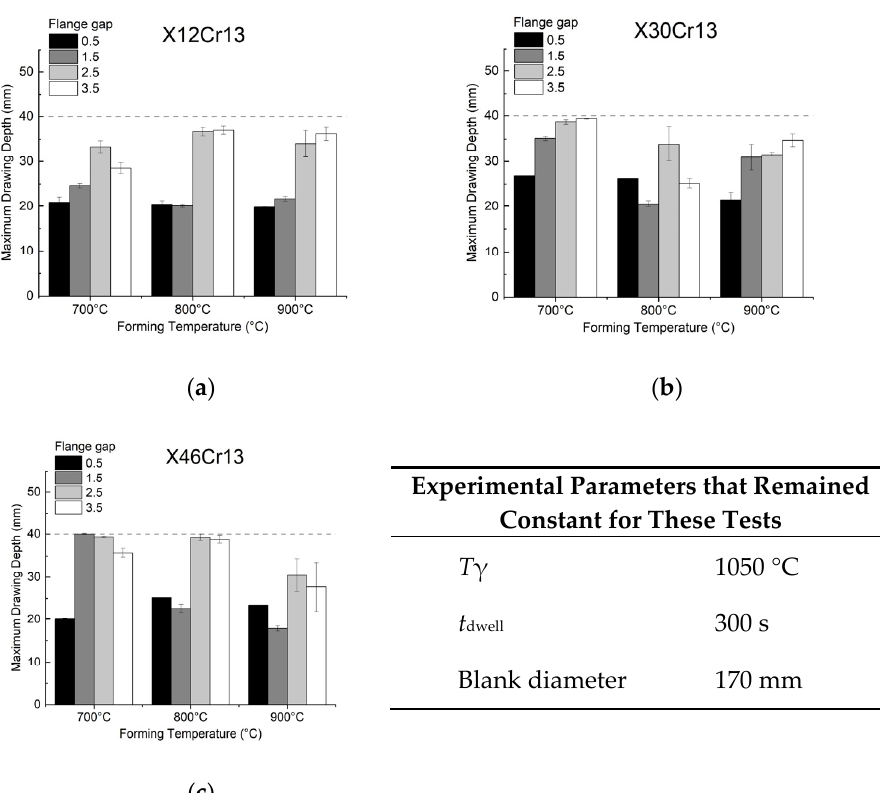
Figure 7. Maximum drawing depth as function of the flange gap and initial forming temperature for the X12Cr13 ( a ), X30Cr13 ( b ), and X46Cr13 ( c ) alloys.